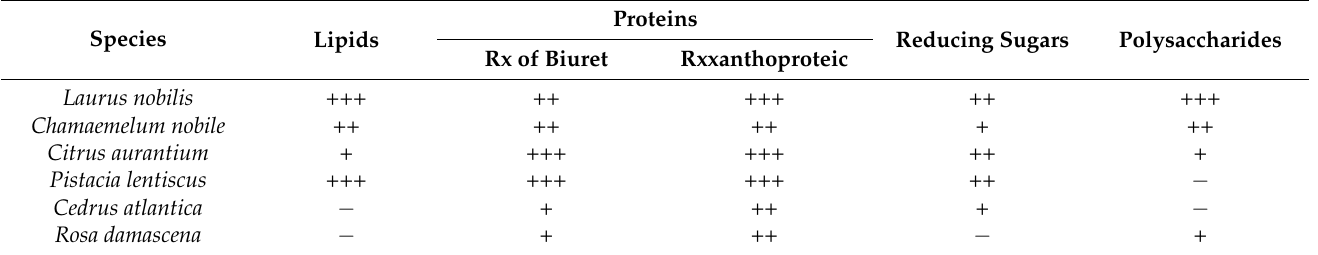
Table 3. Screening of the primary metabolites of the plants studied.